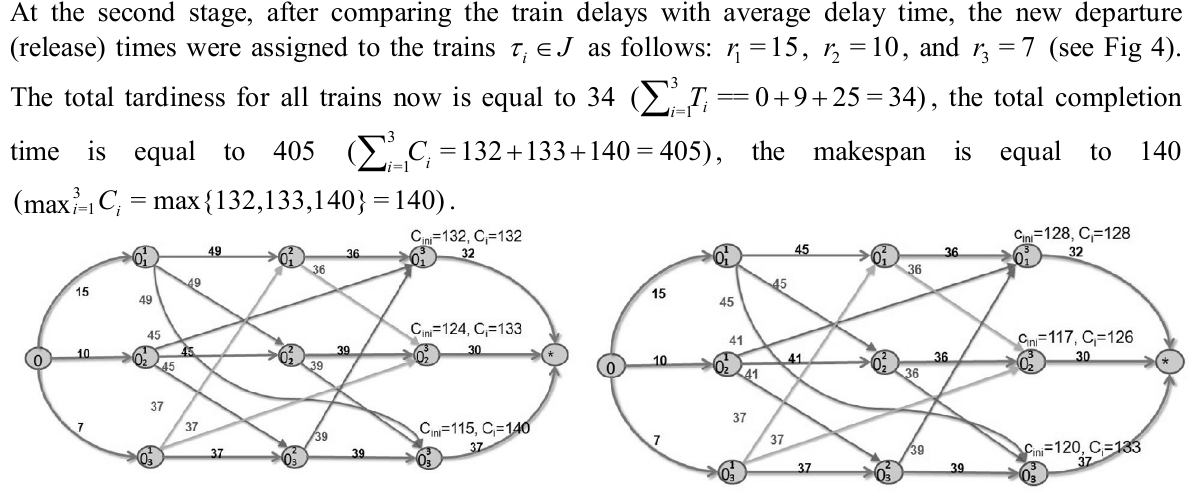
Fig. 4. The modified departure (release) times Fig. 5. Directed graph